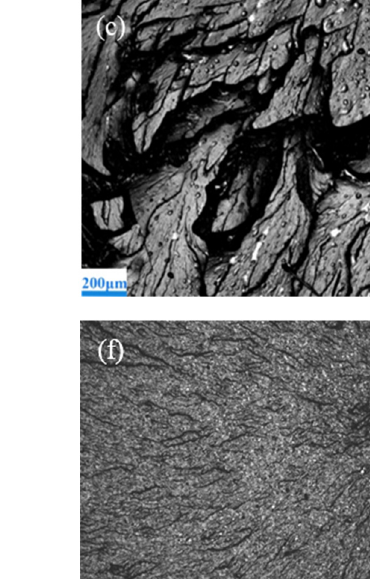
Table 5. Bacterial colony concentration and removal rate.